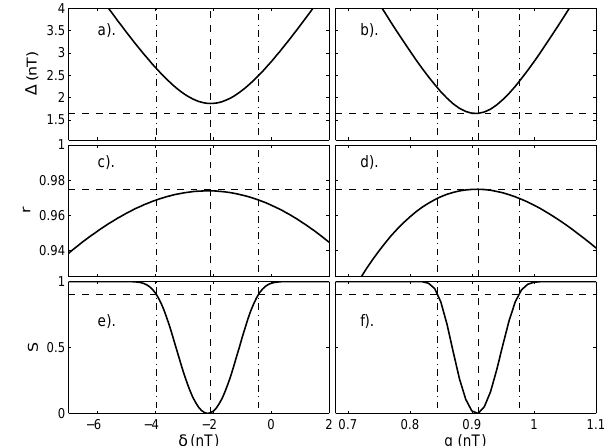
Fig. 1. (left) Annual means of the standard (uncorrected) aa index (in red) and of Ap 0 , the Ap index, linearly regressed against the stan- dard aa index using regression coefficients determined using data taken before 1957 (in blue). (right) Monthly means of aa as a func- tion of Ap 0 for (green dots) before 1957 and (mauve dots) for 1957 and after.